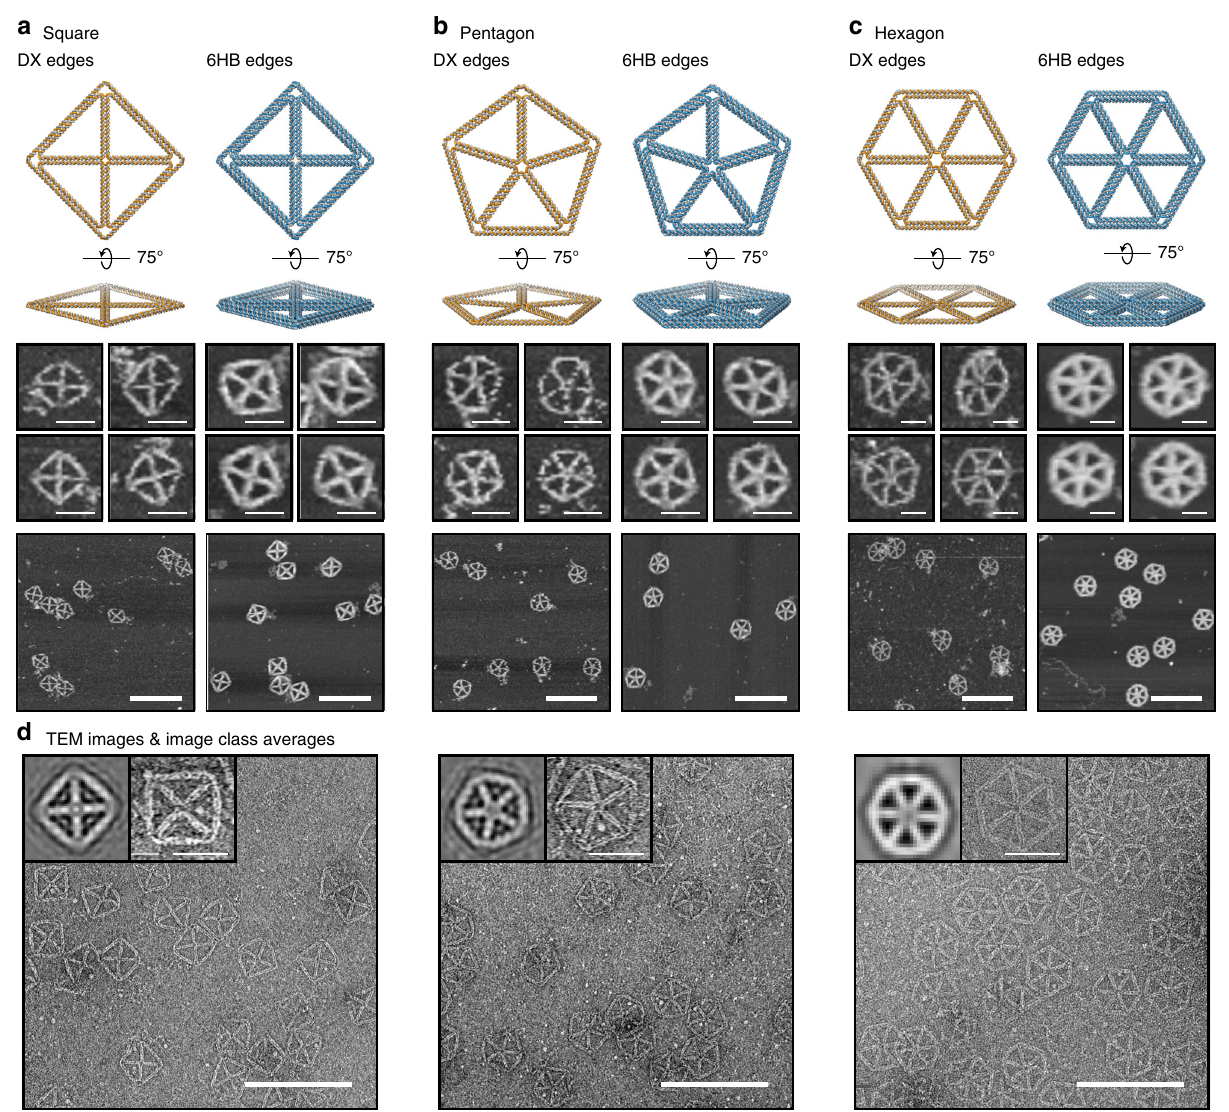
Fig. 2 Designing variable vertex numbers with DX- and 6HB-based 2D DNA origami objects of 84-bp edge length. The square a , pentagon b , and hexagon c consisting of variable vertex numbers are characterized using AFM. (middle) The top zoomed-in images in each panel are representative objects that are deformed and the two images below these represent objects that are undeformed in shape, where all images are taken from the wide- fi eld view shown beneath. d TEM micrographs including zoomed-out and class average images show monodisperse 6HB-based N -sided polygons. Scale bars in zoomed-in and zoomed-out AFM and TEM images are 50 and 200 nm,